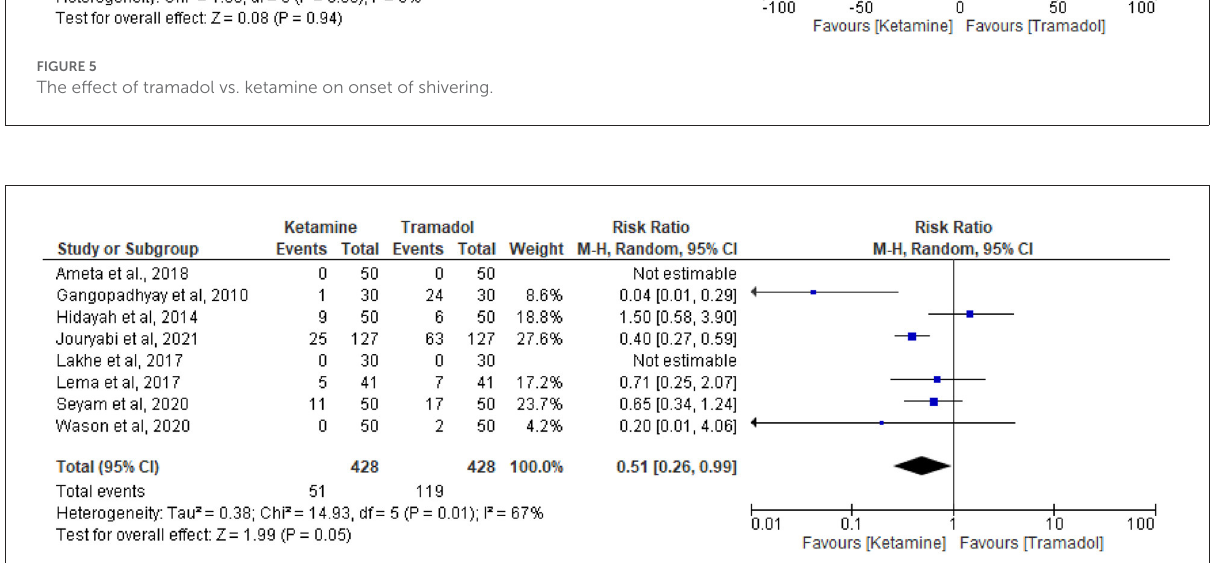
FIGURE6 The effect of tramadol vs. ketamine on the occurrence of nausea and/or vomiting.